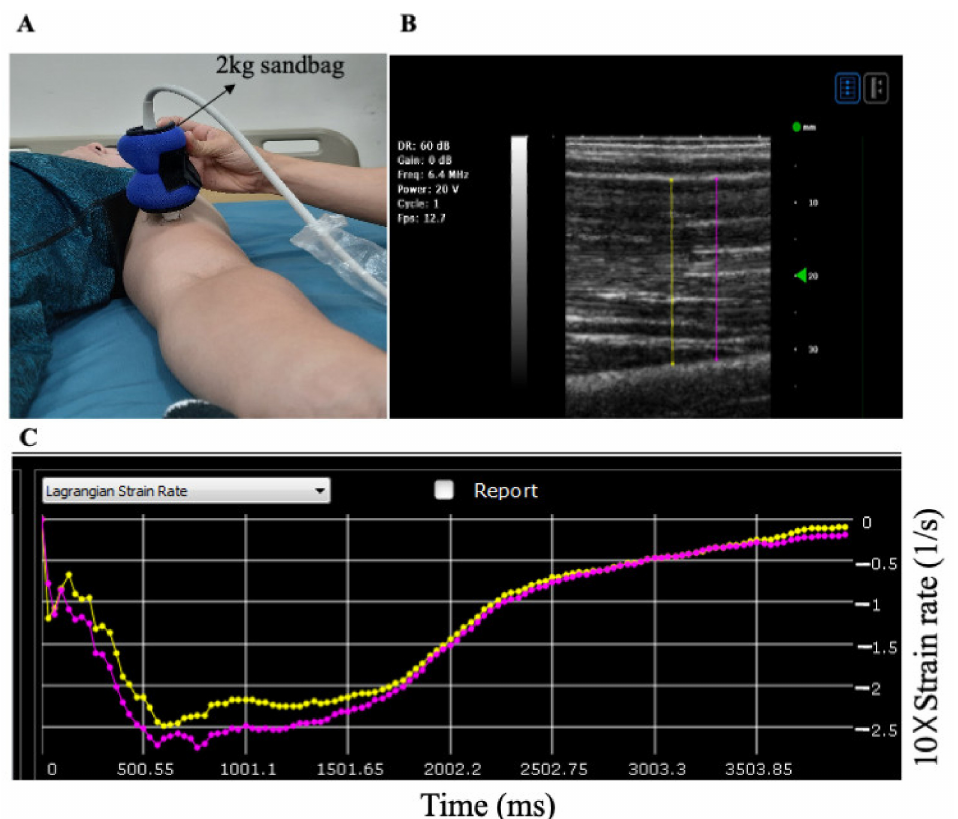
Figure 1. Muscle stiffness measurement. ( A ) The ultrasound probe was placed on the mid-point of the biceps brachii of the upper arms; ( B ) the pixel tracking of two different lines (~1 cm apart) was analyzed by the software (Muscle Tracer, S-Sharp Corp. Taiwan); ( C ) the average strain rate and area under the curve (AUC) calculated from two lines throughout the protocol were